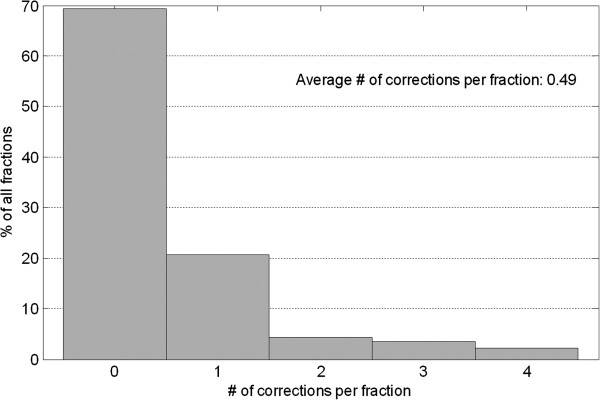
Histogram of per-fraction online correction frequency.